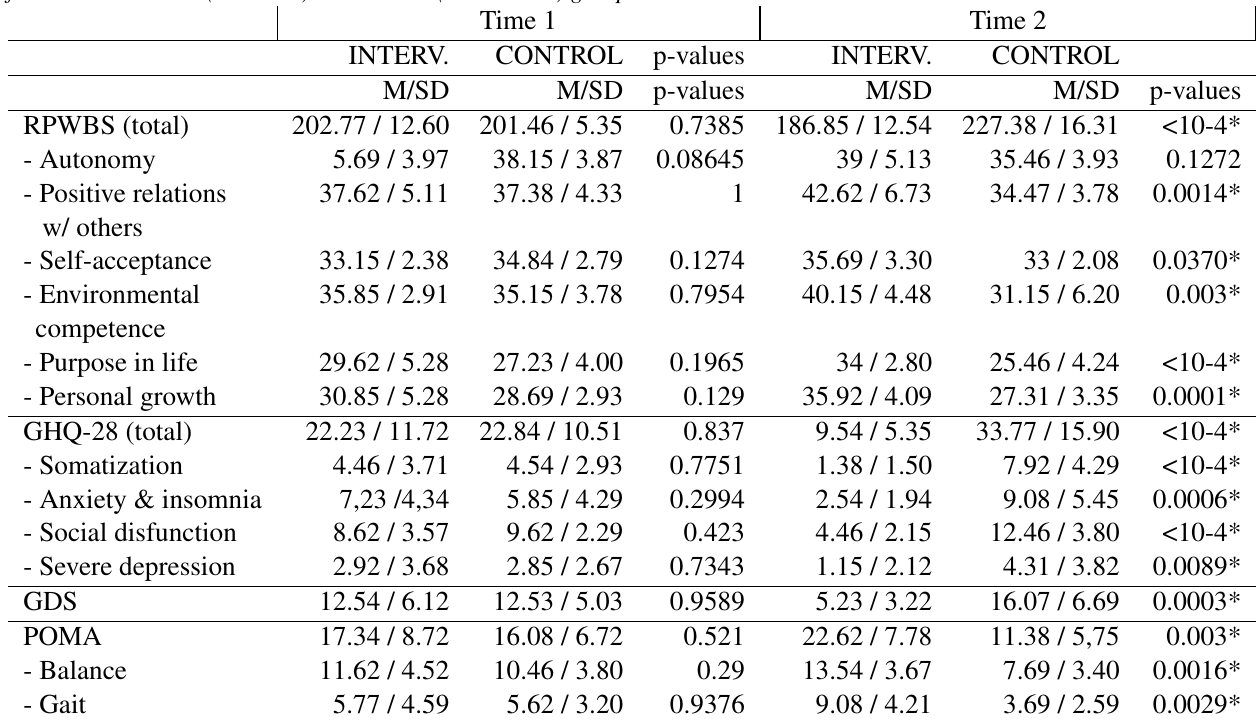
Table 1 Mean, standard deviations, and p-values of the study variables before (time 1) and after the intervention (time 2) for the intervention (INTERV.) and control (CONTROL) groups